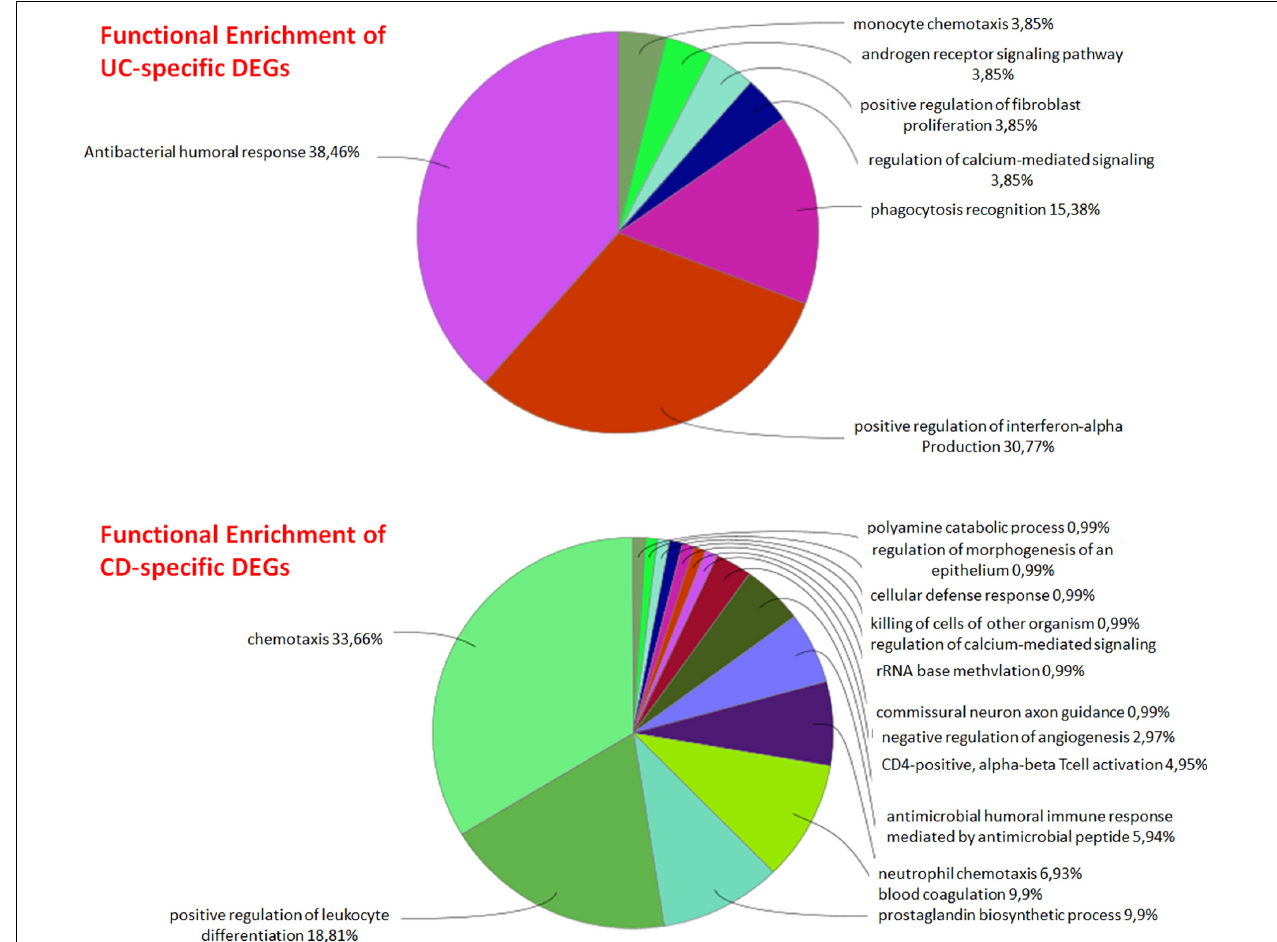
FIGURE 2 | Functional enrichment of UC- and CD-specific differentially expressed genes